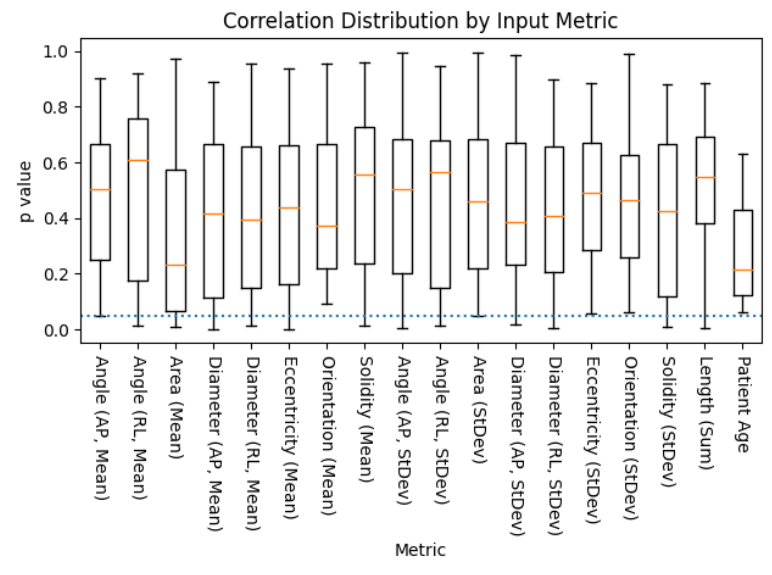
Figure 6. A box plot of the distribution p -values of metric to mJOA score correlations, across all combinations of acquisition contrast, orientation, and segmentation algorithm, as evaluated via SciKit- Learn’s ‘f_regression’ algorithm (lower is better). Age was included as a control, as it has been previously shown to be correlated with mJOA score [32]. The dotted blue line represents the threshold of significance for this study ( p < 0.05), with whiskers representing the maximum/minimum value of the set, or 1.5 times the inter-quartile range, whichever is